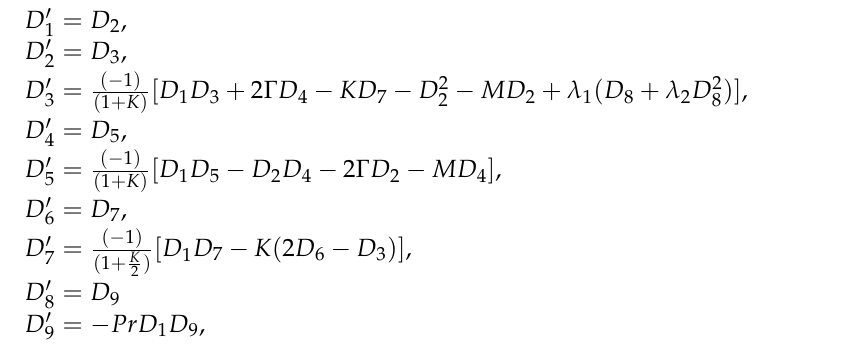
( 0 ) and F (cid:48) ( 0 ) values along variational inputs of Γ when ignoring other 2 1